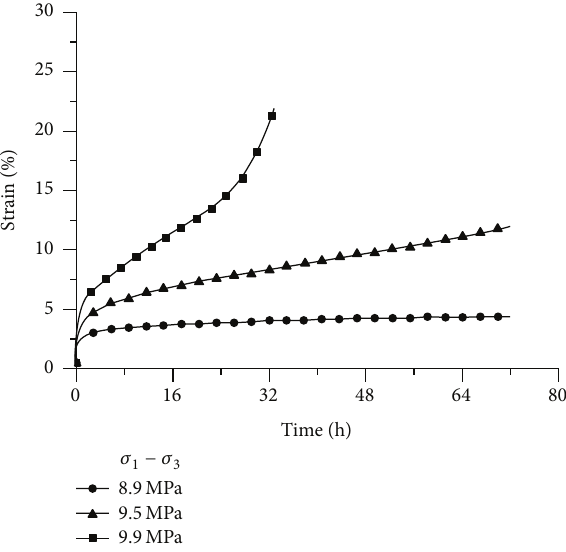
Figure 3: The triaxial creep curves of frozen silt at − 8 ∘